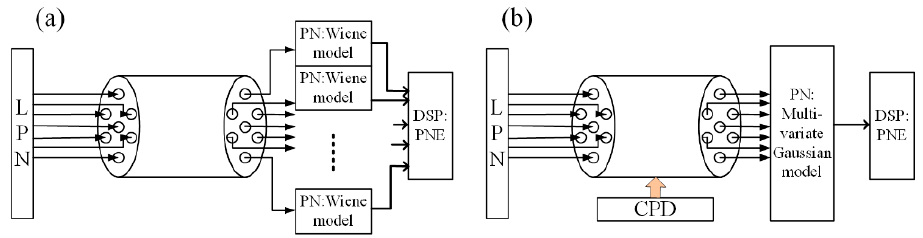
Figure 2. Schematic diagram of phase noise model ( a ) traditional MCF and ( b ) multivariate Gaussian model.